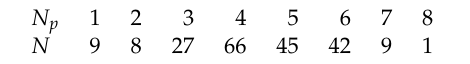
Table 3. The number of graphs with N p isolated pentagonal parts.